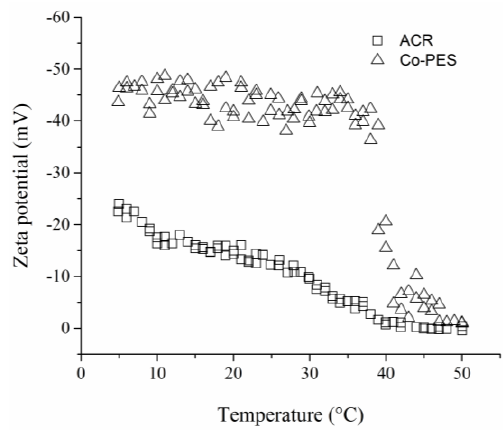
Figure 8. Zeta potential temperature dependence of modified ACR dispersion ( squares ) and Co-PES dispersion ( triangles ).